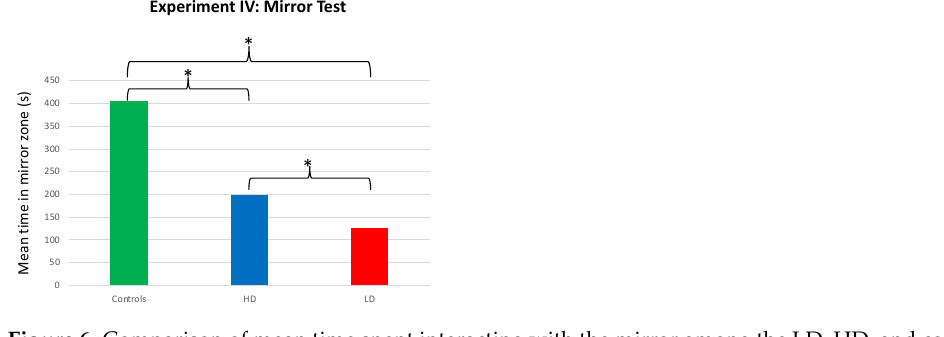
Figure 6. Comparison of mean time spent interacting with the mirror among the LD, HD, and control males of expt. IV. Starred brackets (*) indicates a significant difference in mean mirror time between the treatment groups.